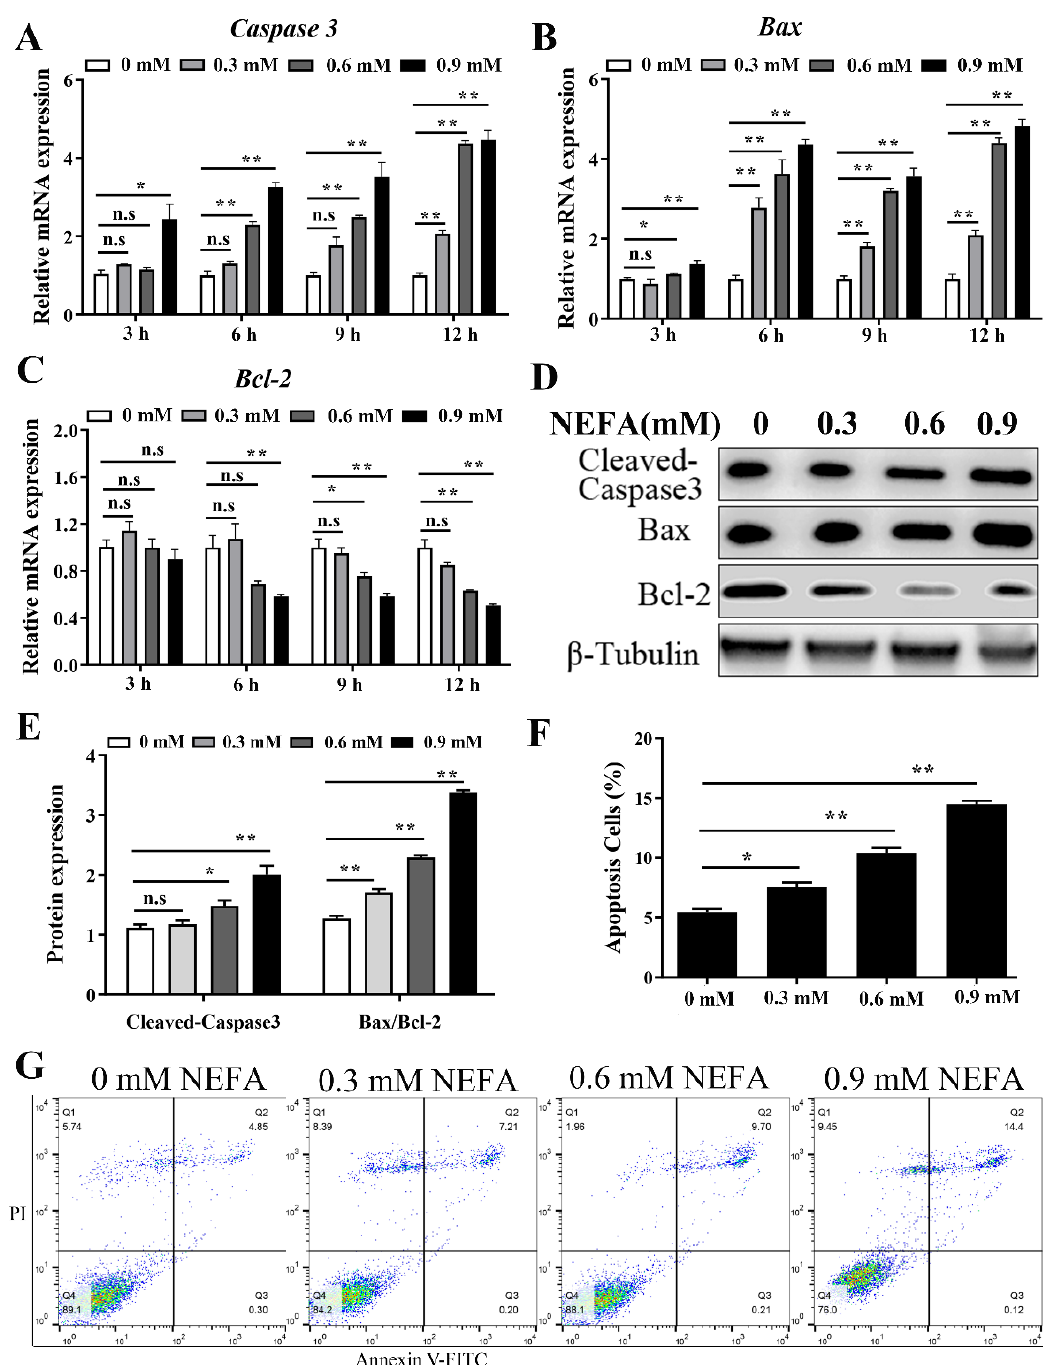
Figure 3. NEFA induced apoptosis in BMECs. ( A – C ) Relative mRNA expression of Caspase3, Bax, and Bcl2 in BMECs after treatment with various concentrations (0.3, 0.6, and 0.9 mM) of NEFA for 3, 6, 9, and 12 h. ( D , E ) Protein expression of Caspase3, Bax, and Bcl2 in BMECs stimulated with the different concentrate of NEFA for 6 h. ( F , G ) Cell apoptosis detected by flow cytometry using annexin V FITC/PI double staining. Data are presented as the means ± the standard errors of the mean (SEM) of three independent experiments. * p < 0.05; ** p <